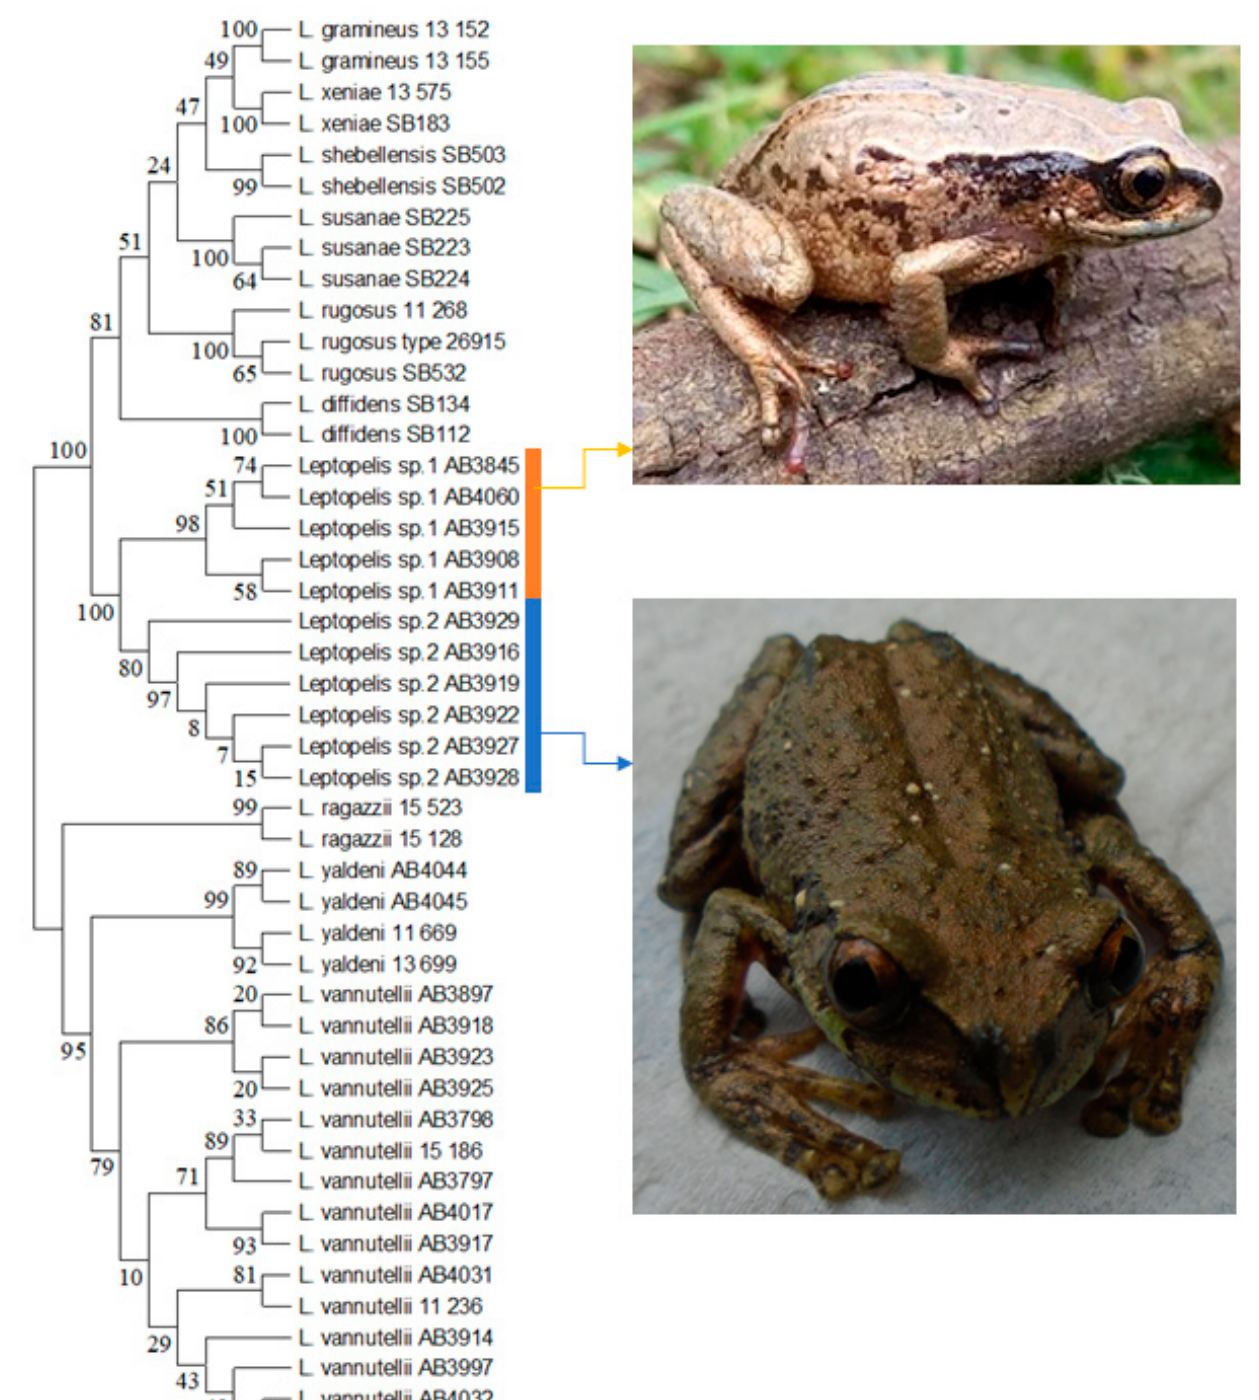
Figure 4. Evolutionary analysis by Maximum Likelihood method. The evolutionary history was inferred by using the Maximum Likelihood method and the Tamura–Nei model [60]. The percentage of trees in which the associated taxa clustered together is shown next to the branches. Initial tree(s) for the heuristic search were obtained automatically by applying Neighbor-Join and BioNJ algorithms to a matrix of pairwise distances estimated using the Tamura–Nei model, and then selecting the topology with superior log likelihood value. This analysis involved 46 nucleotide sequences. The orange color band represents Leptopelis sp. 1 and the blue color represents Leptopelis sp.